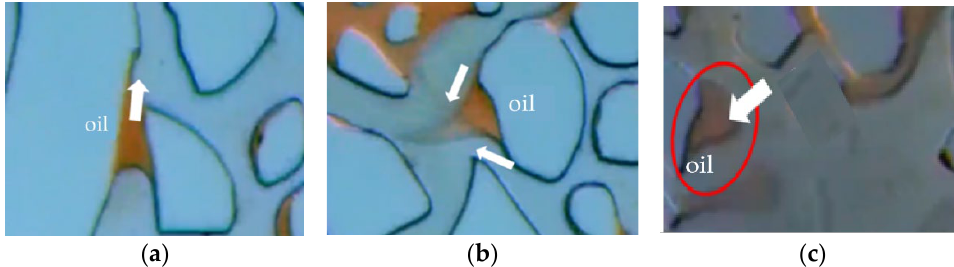
Figure 7. Flow pattern of residual oil in discontinuous phase: ( a ) Columnar; ( b ) Membranous; ( c ) Dropwise.